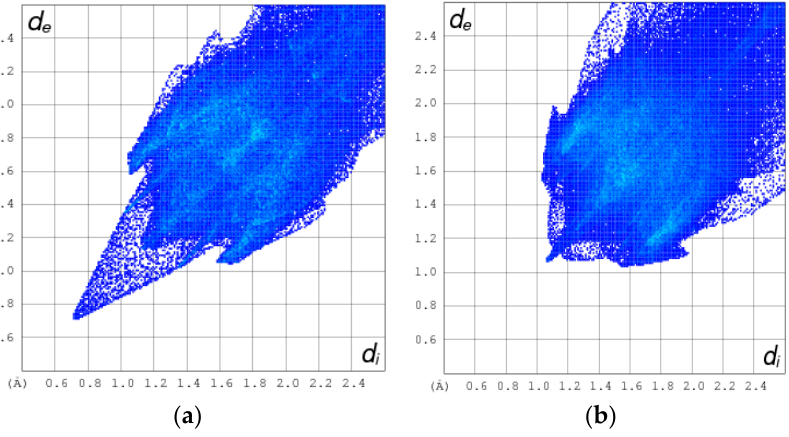
Figure 7. Isosurface of intermolecular interaction: ( a ) of H 2 -TMPP ; ( b ) Cd-TMPP-Pyz.